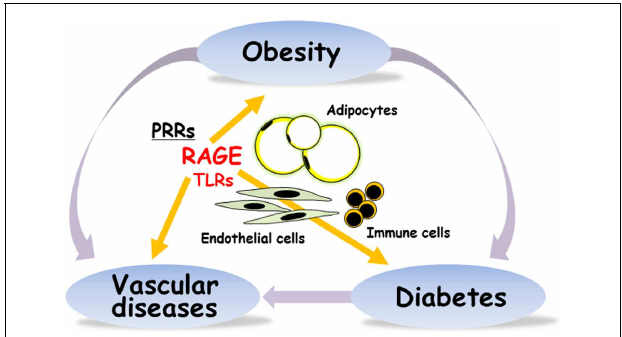
FIGURE 1 | RAGE is implicated in obesity, type 2 diabetes, and vascular diseases . PRRs, pattern-recognition receptors; RAGE, receptor for advanced glycation end-products;TLRs, toll-like